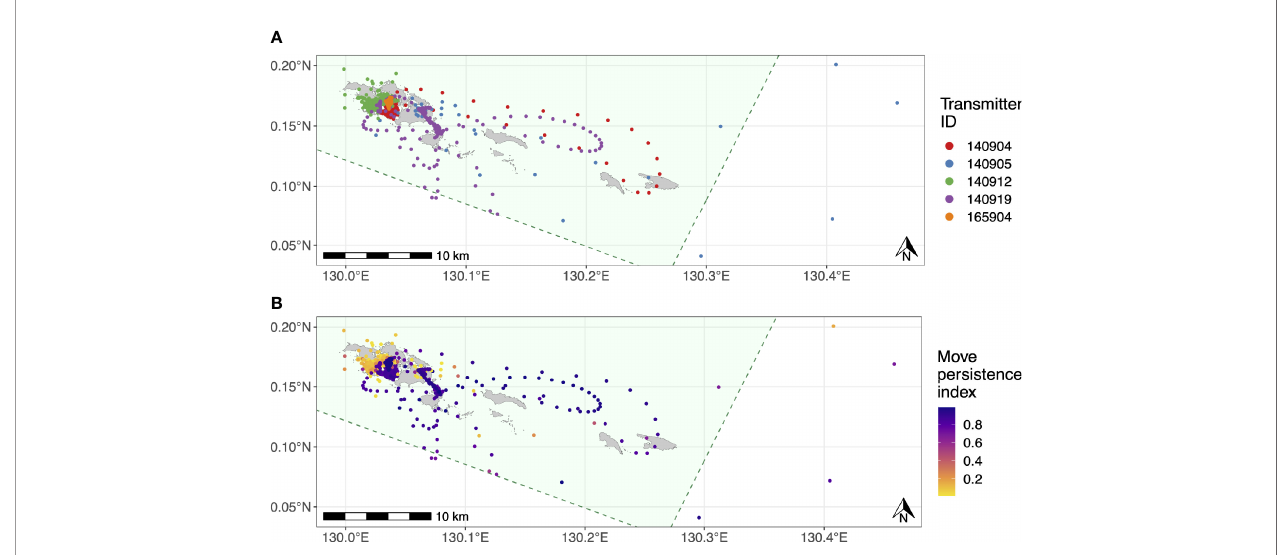
FIGURE 5 | Movement tracks for the fi ve satellite-tracked juvenile M. alfredi estimated using state-space models with six-hour time steps. (A) Most likely track for each tagged individual; (B) Move persistence behavioural indices for all estimated M. alfredi positions. The green polygons in both panels denote SAP Waigeo Barat MPA boundary and the grey polygons represent